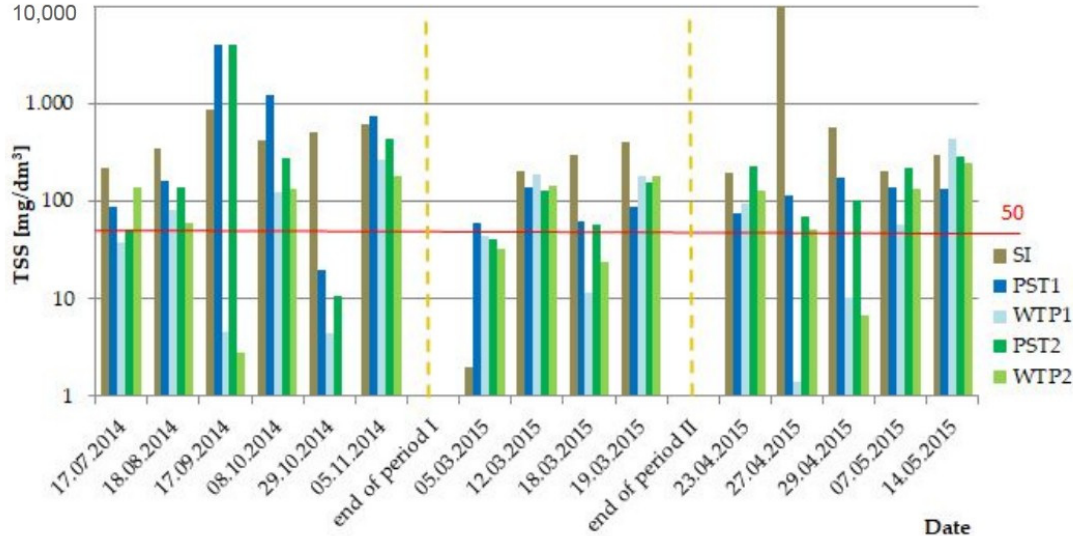
Figure 4. Total suspended solids (TSS) in sewage inlet (SI), after primary settling tank (PST1 and PST2), and after WTP1 and WTP2.